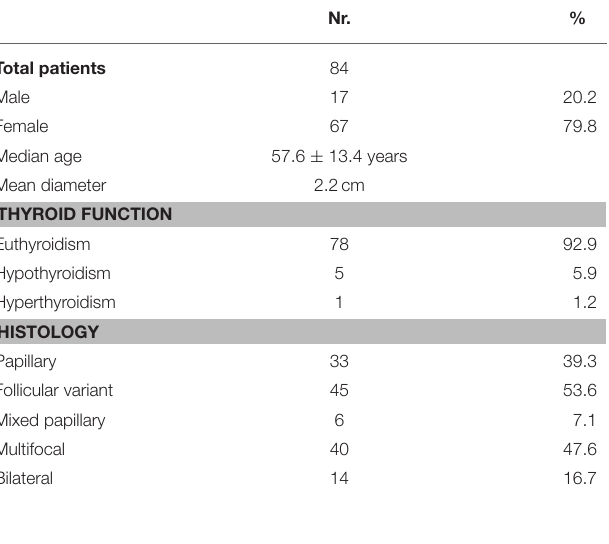
TABLE 1 | Patients characteristics.